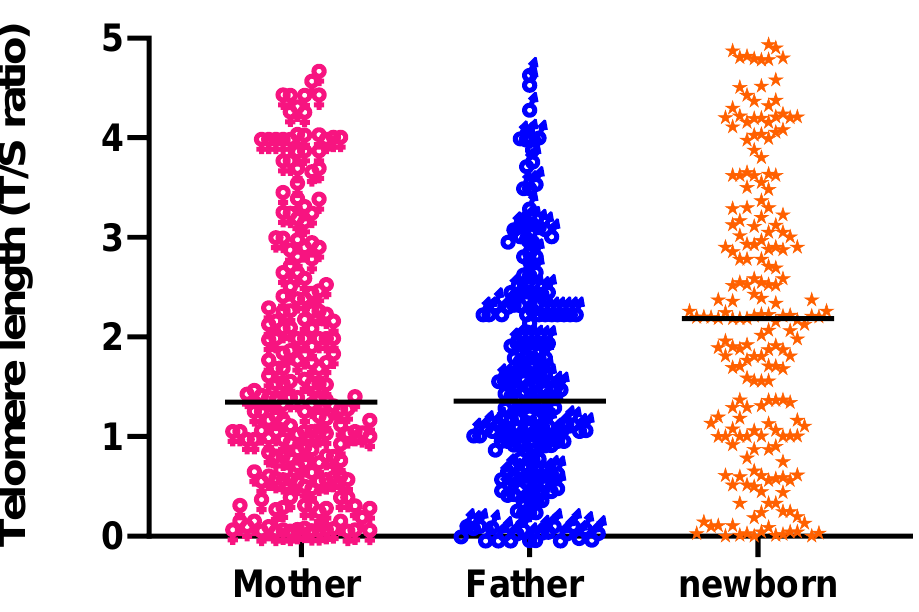
Figure 1. Telomere length (T/S ratio) comparison between mother, father and newborn. Newborn TL was longer, followed by mother and father TL.